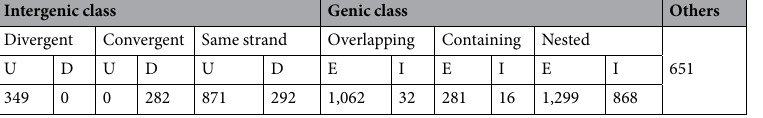
Table 3. Classification of non-coding transcripts. U, upstream; D, downstream; E, exonic; I, intronic. Definitions for different classes and sub-classes were described in the initial